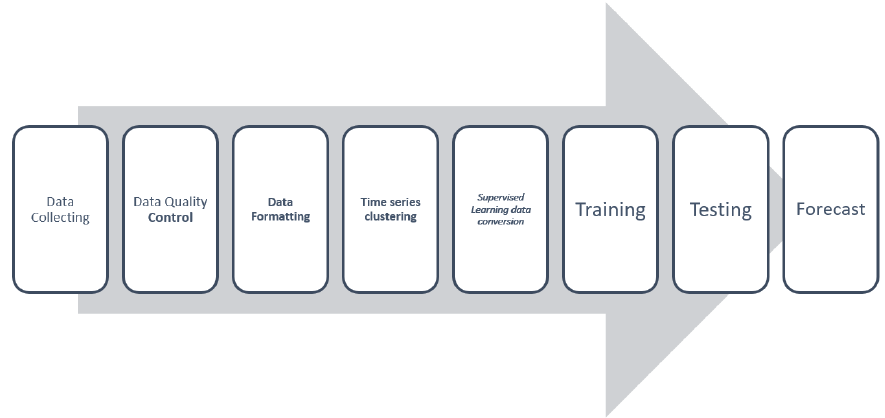
Fig. 2. Forecasting steps in determining the weekly new cases of COVID- in West Java using